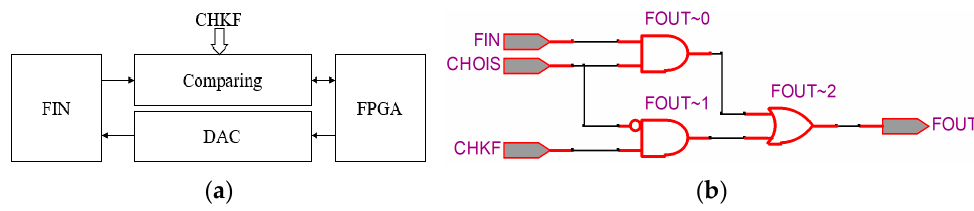
Figure 3. Self-Calibration/Frequency Measurement Selection Module. ( a ) Working cells, ( b ) designed